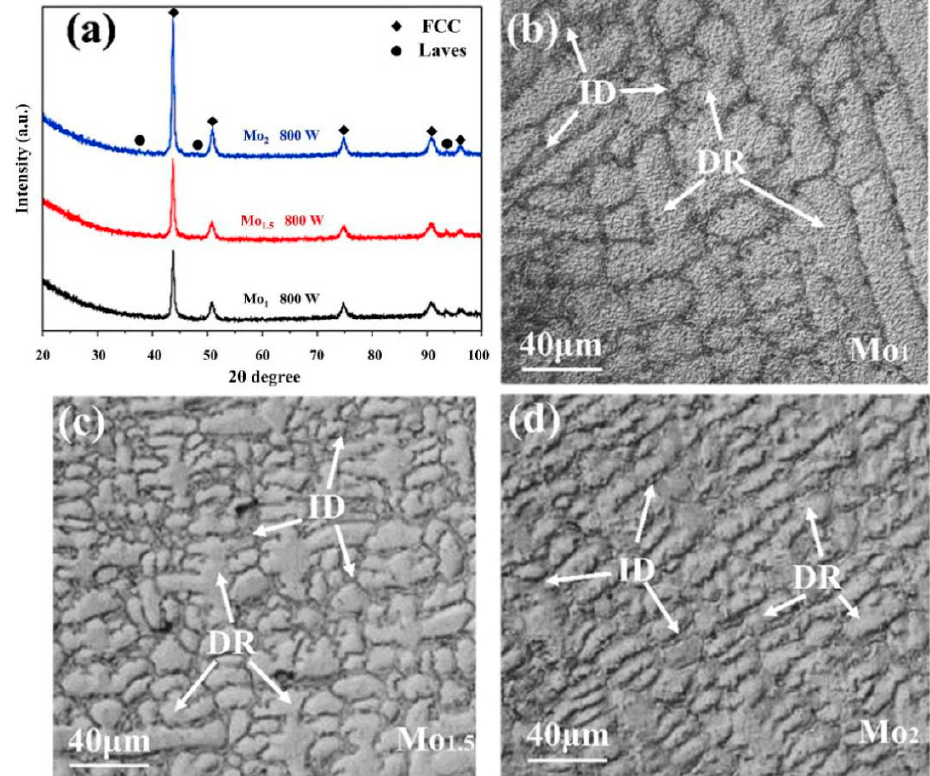
Figure 10. ( a ) XRD patterns for the HEA coatings ((CoCrFeNi) 95 Nb 5 ) 100 − x Mo x ( x = 1, 1.5, 2), ( b – d ) SEM images for the microstructure of the HEA coatings ((CoCrFeNi) 95 Nb 5 ) 100 − x Mo x ( x = 1, 1.5, 2). Reprinted with permission from Ref. [71]. Copyright 2021 MDPI.